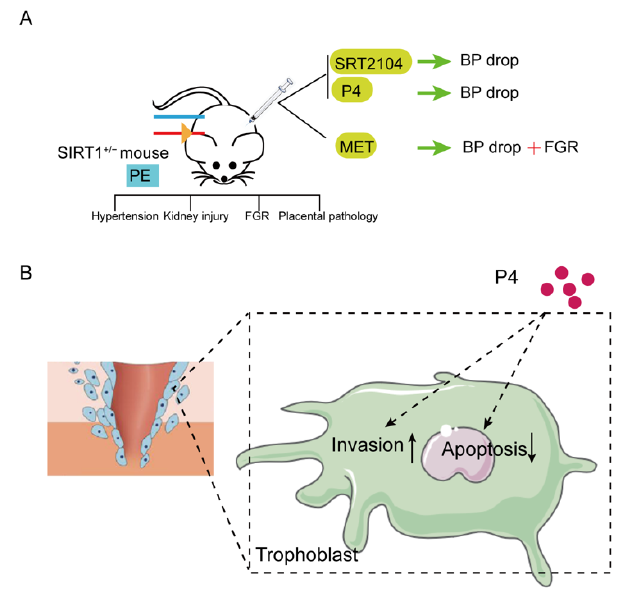
Figure 5. Summary diagram. ( A )SIRT1 knockdown (SIRT1 +/ − ) mice showed typical pre-eclampsia- like symptoms, such as hypertension, kidney injury, FGR, and placental pathology. These perfor- mances could be improved after intraperitoneal injection of SIRT1 agonist SRT2104 and P4. Metformin could also reduce the elevated blood pressure, but caused FGR. ( B ) Additionally, P4 could promote the invasion and inhibit the apoptosis of trophoblasts. (PE: pre-eclampsia; FGR: fetal growth restriction; P4: progesterone; Met: metformin.).